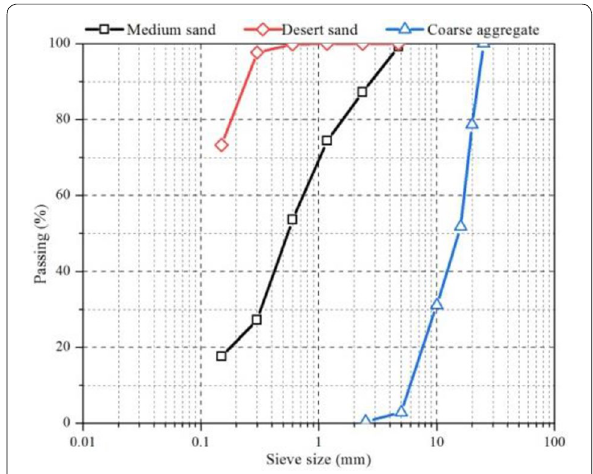
Fig. 1 Particle distribution of coarse and fine